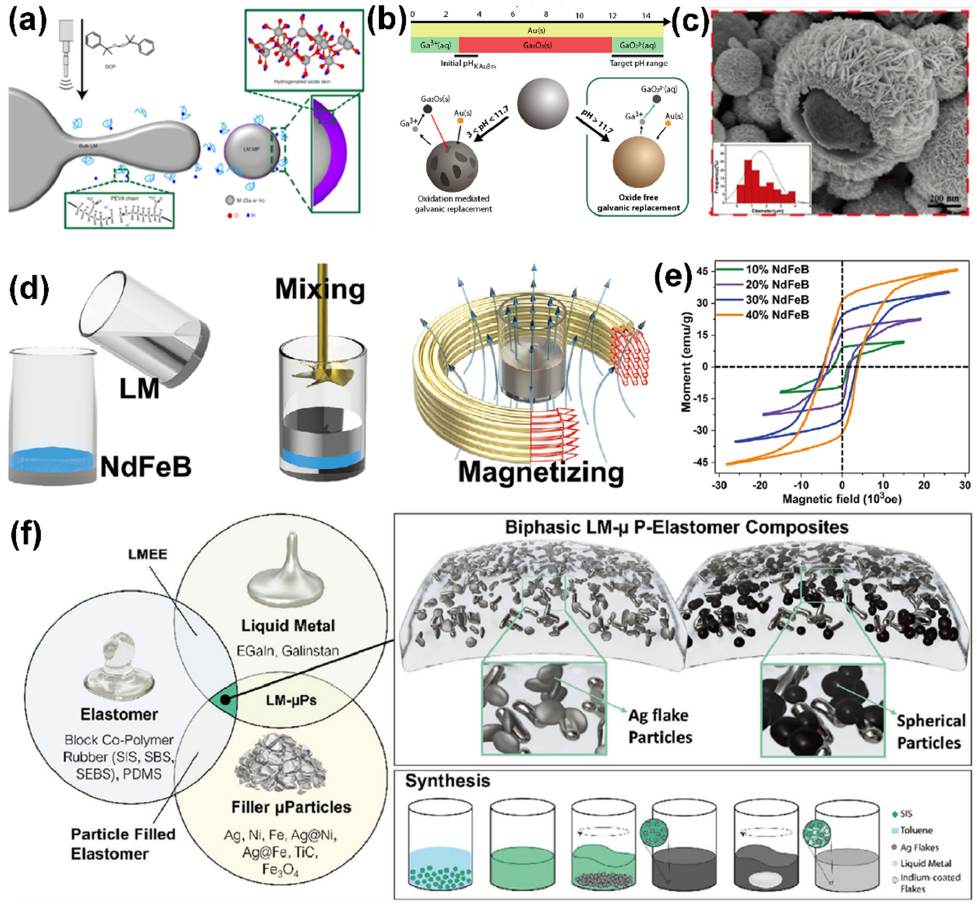
Figure 3. Liquid metal-oxide/metal composites. ( a ) H-doped LM. Reprinted with permission from Ref. [48] Copyright 2021 Springer Nature. ( b ) Au-coated LM. Reprinted with permission from Ref. [51] Copyright 2018 American Chemical Society ( c ) Ag-coated LM. Reprinted with permission from Ref. [26] Copyright 2020 John Wiley and Sons ( d ) Illustration of the FM-LM preparation process. ( e ) Magnetization hysteresis loops of FM-LM under different NdFeB weight fractions. Reprinted with permission from Ref. [54] Copyright 2020 John Wiley and Sons. ( f ) The constitutional materials and synthesis of binary and trinary LM composites. Reprinted with permission from Ref. [55] Copyright 2022 John Wiley and Sons. 2.2. Liquid Metal-Ligand Molecule Composites The earliest metal inks were usually metal nanoparticles or metal nanowires dis- persed in an appropriate solvent containing some specific additives to obtain a certain rheological behavior. This is conducive to the formation of uniform and continuous pat- terns during the printing process, and the attachment to the substrate. In order to fabricate functional devices by various printing techniques, the key step is to synthesize conductive LM-based nanomaterials. Because the ink should provide high conductivity of the printed pattern, it is essential that the conductive nanomaterials should have a high concentration and be non-aggregated and stable in the ink. The physical properties of the ink, such as viscosity and surface tension, are also critical to achieving high printing accuracy and res- olution. From this point of view, formulations for printable liquid metals must prevent precipitation and aggregation. Although the presence of an oxide layer can maintain the